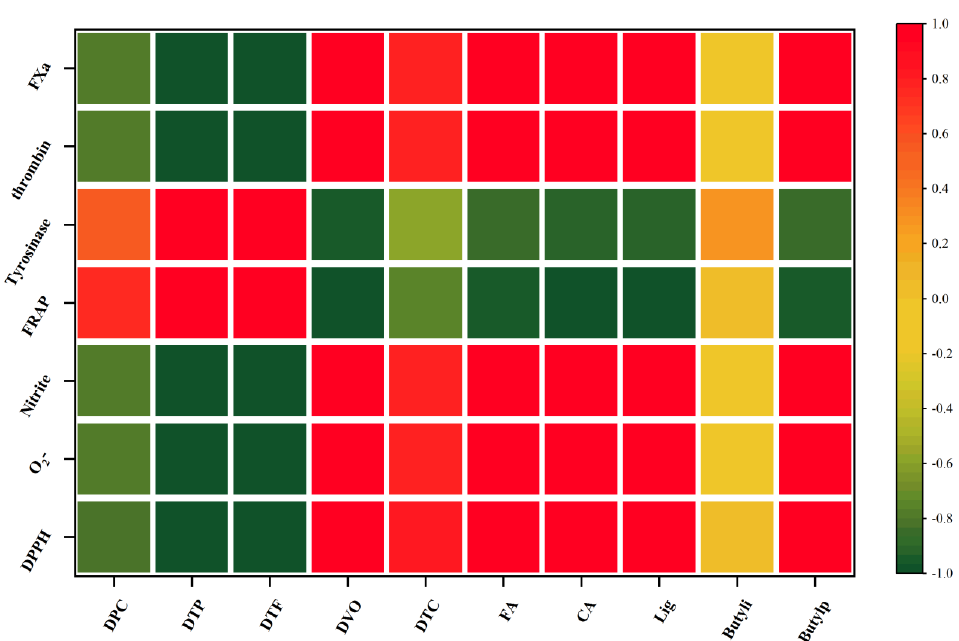
Figure 6. Heat map of correlation analysis of the chemical compounds and biological activity.